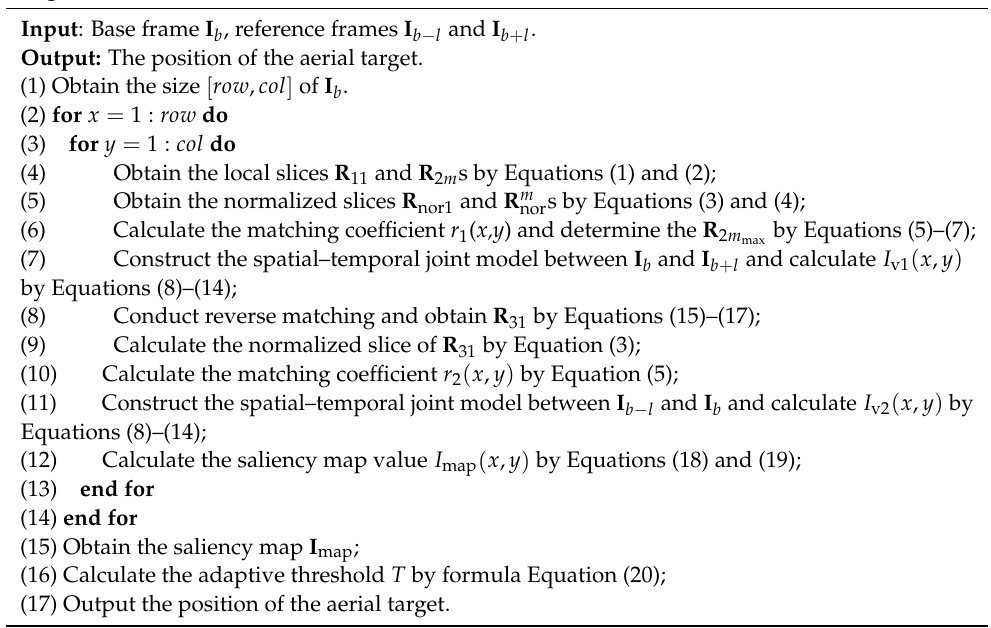
Algorithm 1 Procedure of